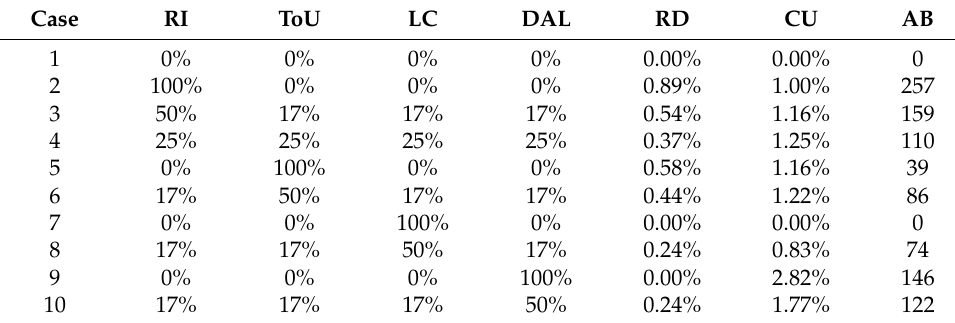
Table 1. Results of the simulations in the base scenario.